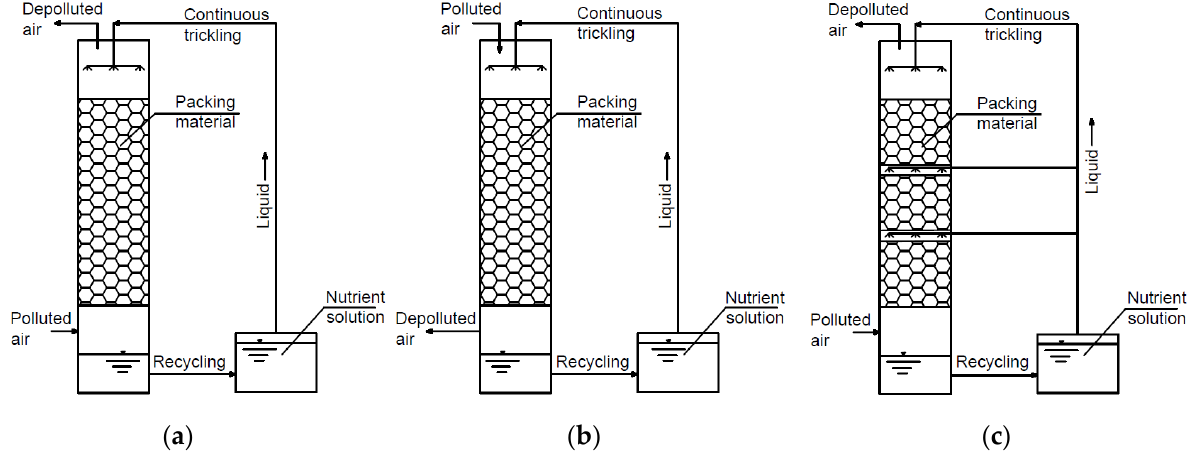
Figure 5. The principal scheme of a biotrickling filter ( a ), co-current biotrickling filter ( b ), biotrickling filter with three-layer packing material ( c ).